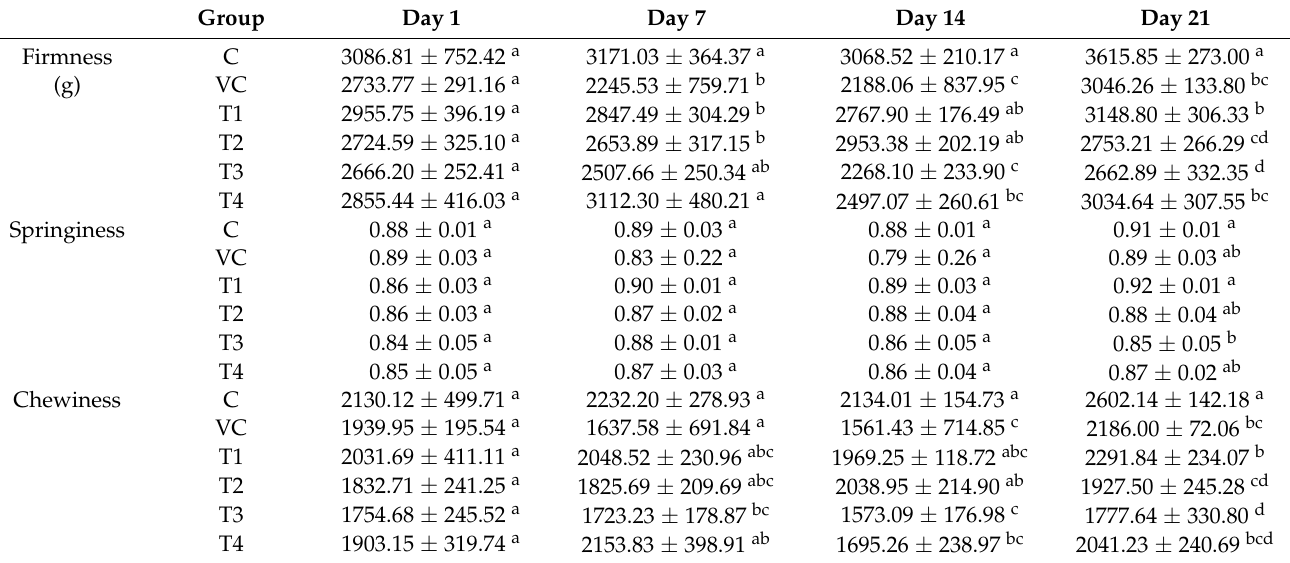
Table 5. Changes of Texture parameters of frankfurters during storage at 4 ◦ C (n =